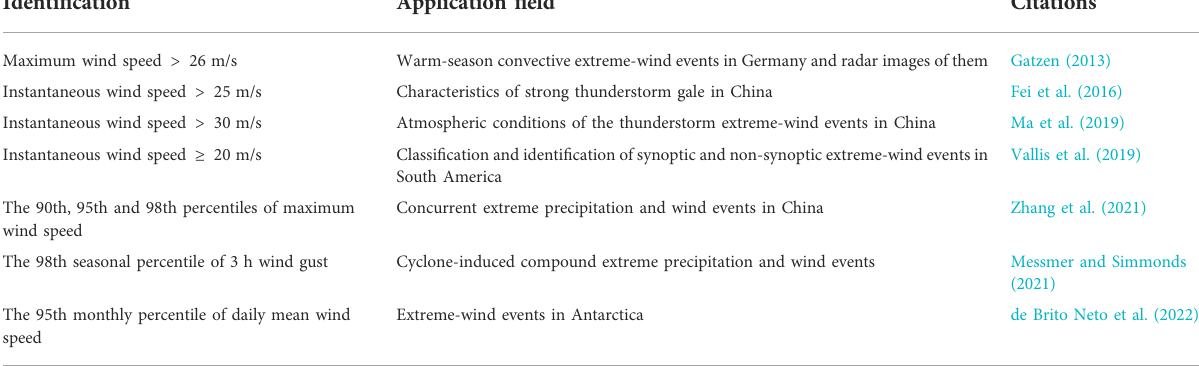
TABLE 1 Identi fi cation threshold of extreme events in previous studies. In this table, gale refers to a maximum wind speed higher than 10.8 m s − 1 , maximumwindspeedmeansthelargest10-minaveragewindspeedinaspeci fi cday,instantaneouswindspeedcanbetheaveragewindspeedin 3 s or 2